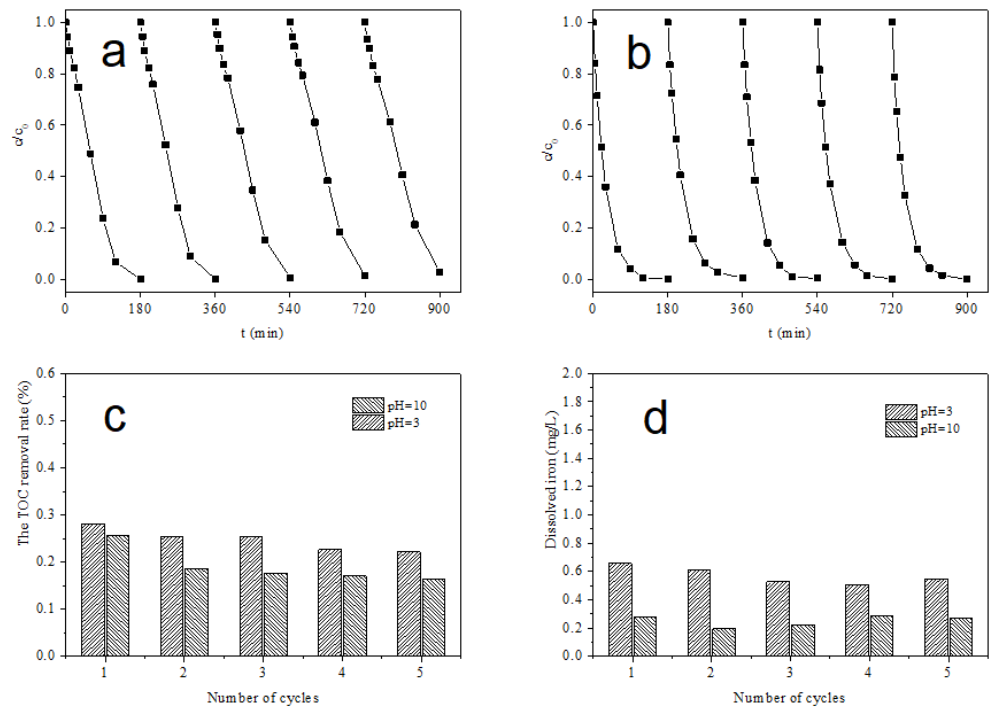
Figure 7. Reusability of the granular catalyst under acidic ( a ) and alkaline ( b ) conditions and mineralization rate of Rhodamine B ( c ) and iron dissolution amount ( d ).